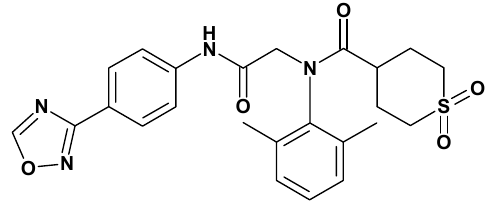
Figure 1. Molecular structure of